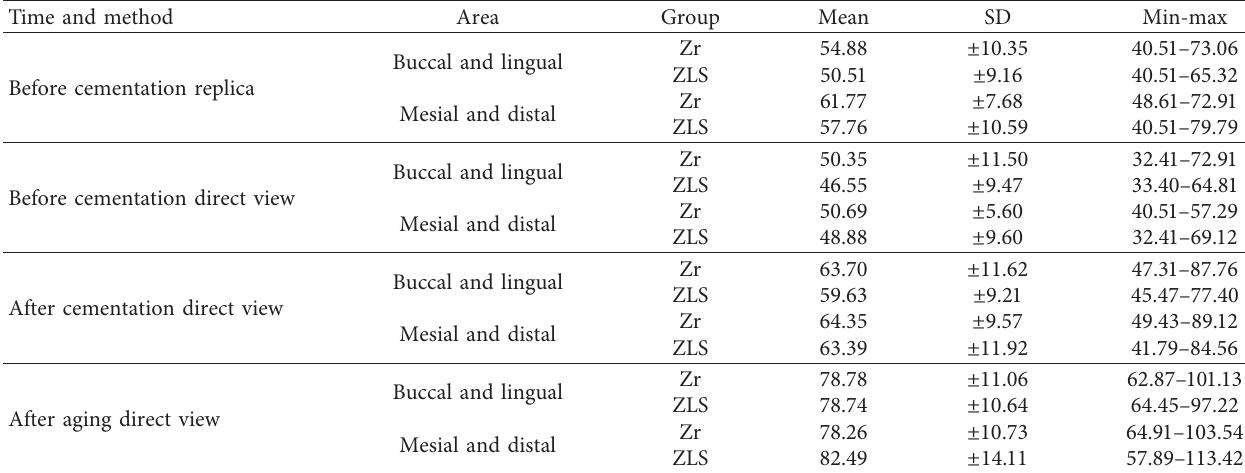
Table 4: Mean marginal gaps and standard deviations of buccal-lingual and mesial-distal surfaces (separately) at different measurement